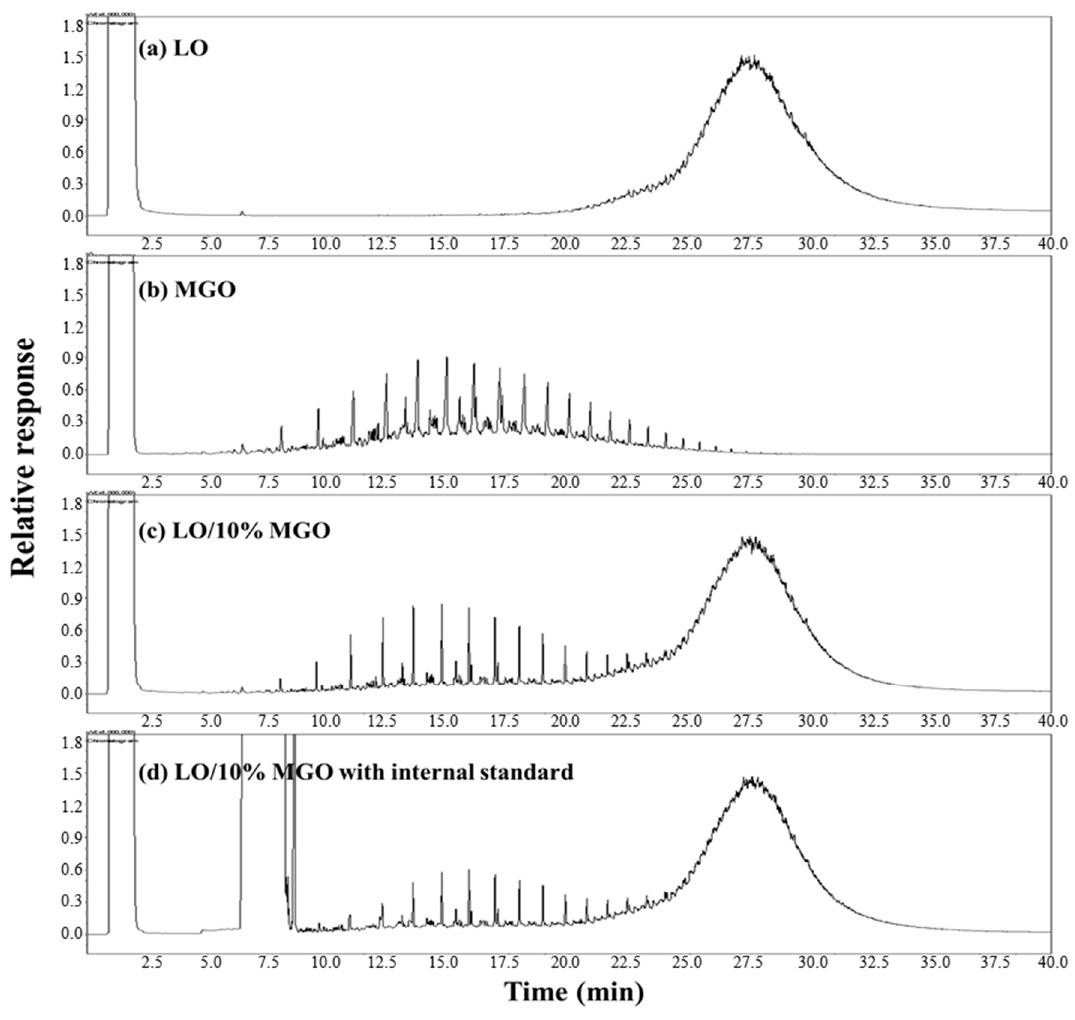
Figure 1. Gas chromatogram of ( a ) commercial lubricating oil (LO), ( b ) marine gas oil (MGO), ( c ) LO/10% MGO, and ( d ) LO/10% MGO with internal standard.